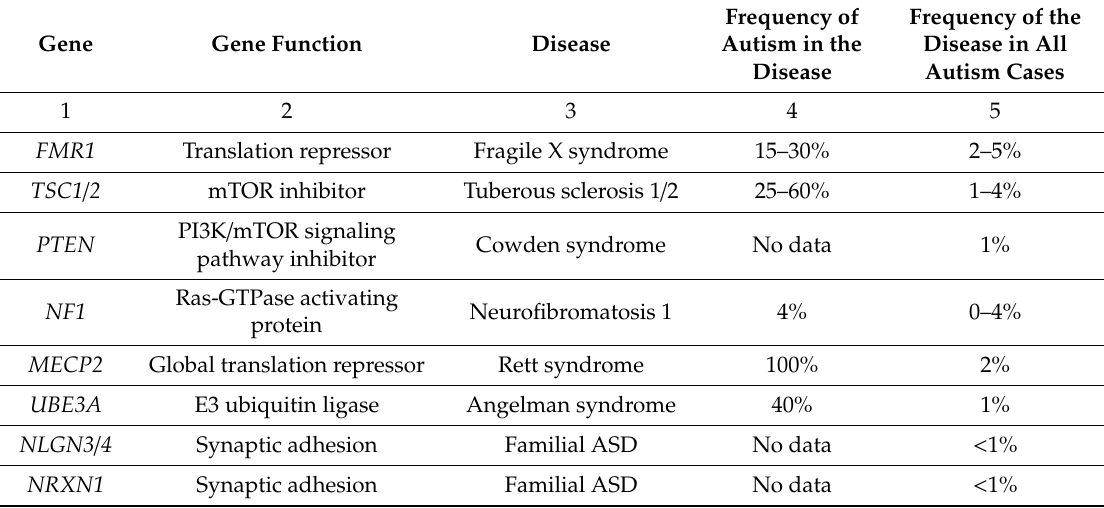
Table 1. Monogenic disorders characterized by a high frequency of autism (syndromic forms of autism). Gene Gene Function Disease